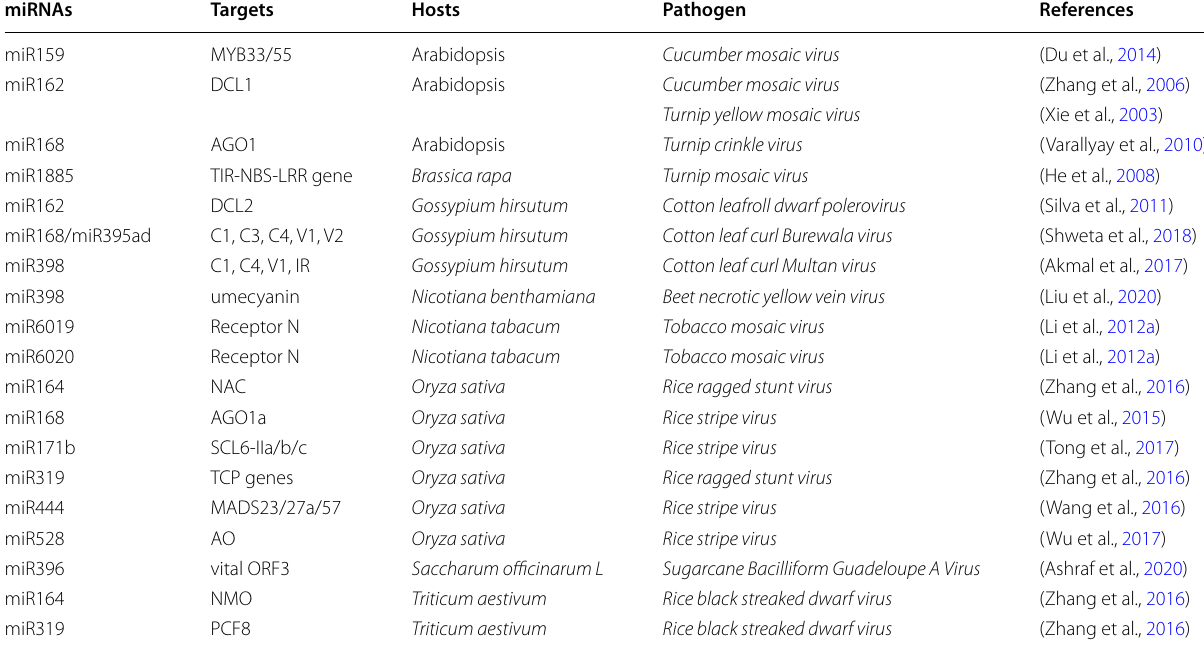
Table 1 List of miRNAs involed in plant-virus interactions